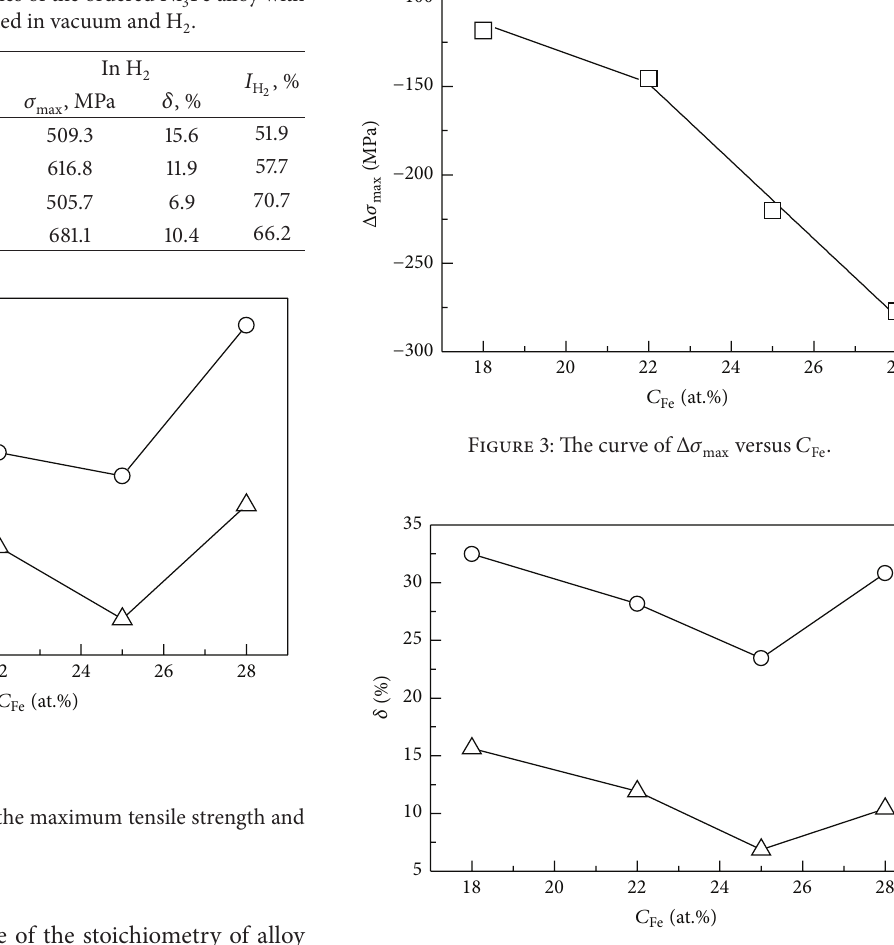
Table 1: The mechanical properties of the ordered Ni different stoichiometry when tested in vacuum and H